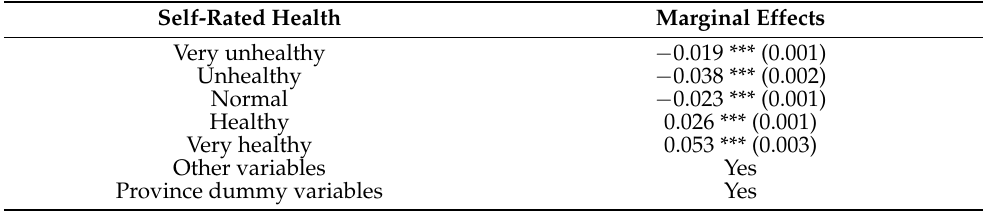
Table 4. Marginal effects of happiness on self-rated health.